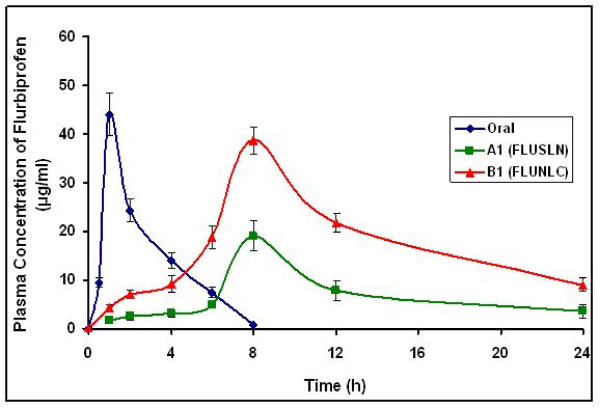
Plasma concentrations of flurbiprofen after oral and transdermal administration (n = 6)